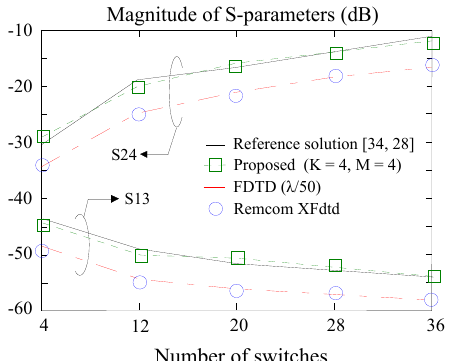
Figure 9: A four-port microwave splitter with a dielectric core and a number of switches. Modeling regions: complex- interface schemes for the switches, optimized FVTD tech- nique for the dielectric and the inclined parts of the structure, and PSTD algorithm for the rest of its interior.